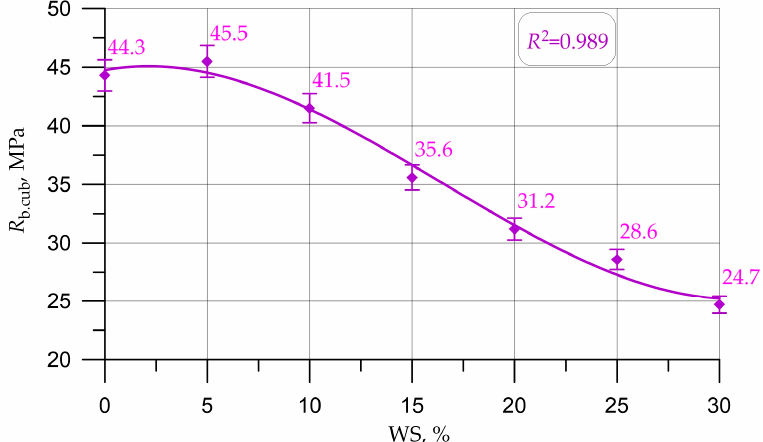
Figure 6. Dependence of the cubic strength of concrete on the amount of walnut shell.